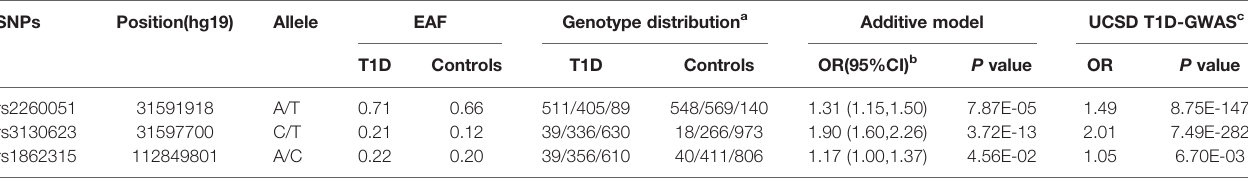
TABLE 1 | Associations between the m6A regulator SNPs in PRRC2A, YTHDC2 gene, and T1D risk. SNPs